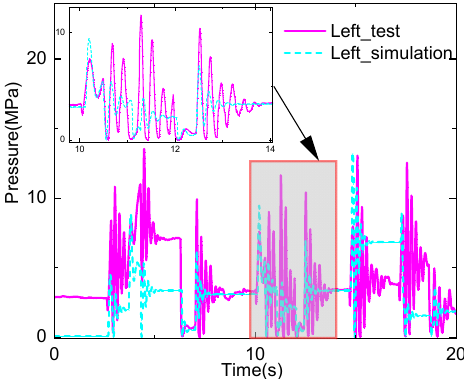
Figure 10. Pressure results of steering system.